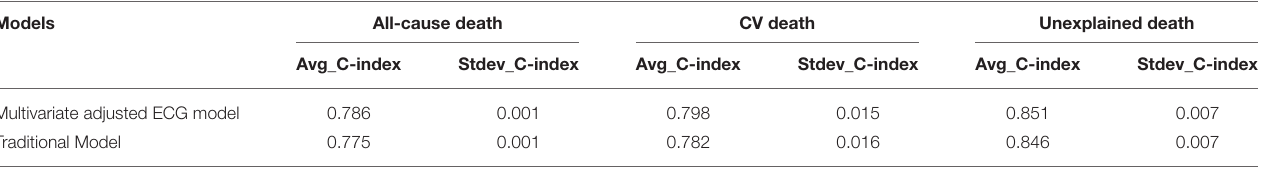
TABLE 4 | Average and standard deviation of c-indices from 10-fold cross-validation.